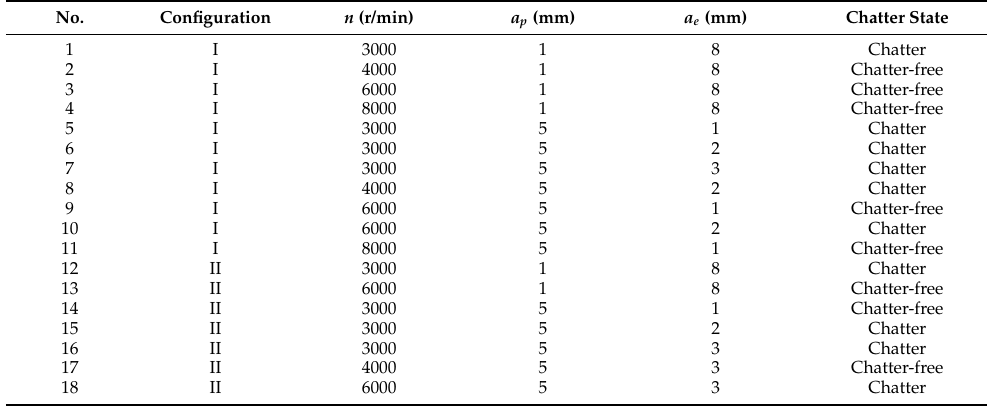
Table 1. Milling parameters and the chatter